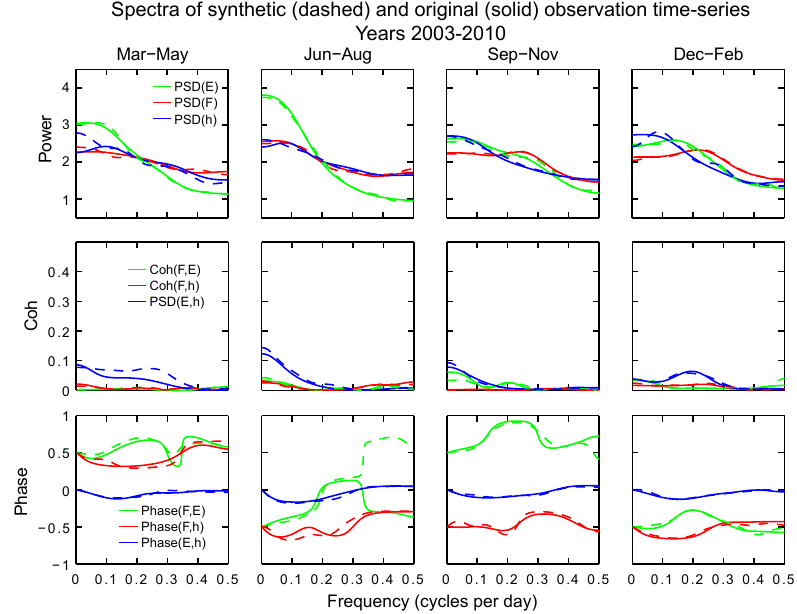
Fig. 2. Top row: power spectral density estimates for entrainment ( E , green lines), surface and horizontal CO 2 flux ( F , red lines), and boundary layer height ( h , blue lines) for original observational time series (solid) and synthetic observational time series (dashed) for each season, normalized in order to have equal area under each curve. Middle row: coherence spectra corresponding to the cross-spectral densities CSD F,E (green), CSD F,h (red), and CSD E,h (blue). Bottom row: phase spectra corresponding to the cross-spectral densities CSD F,E (green), CSD F,h (red), and CSD E,h